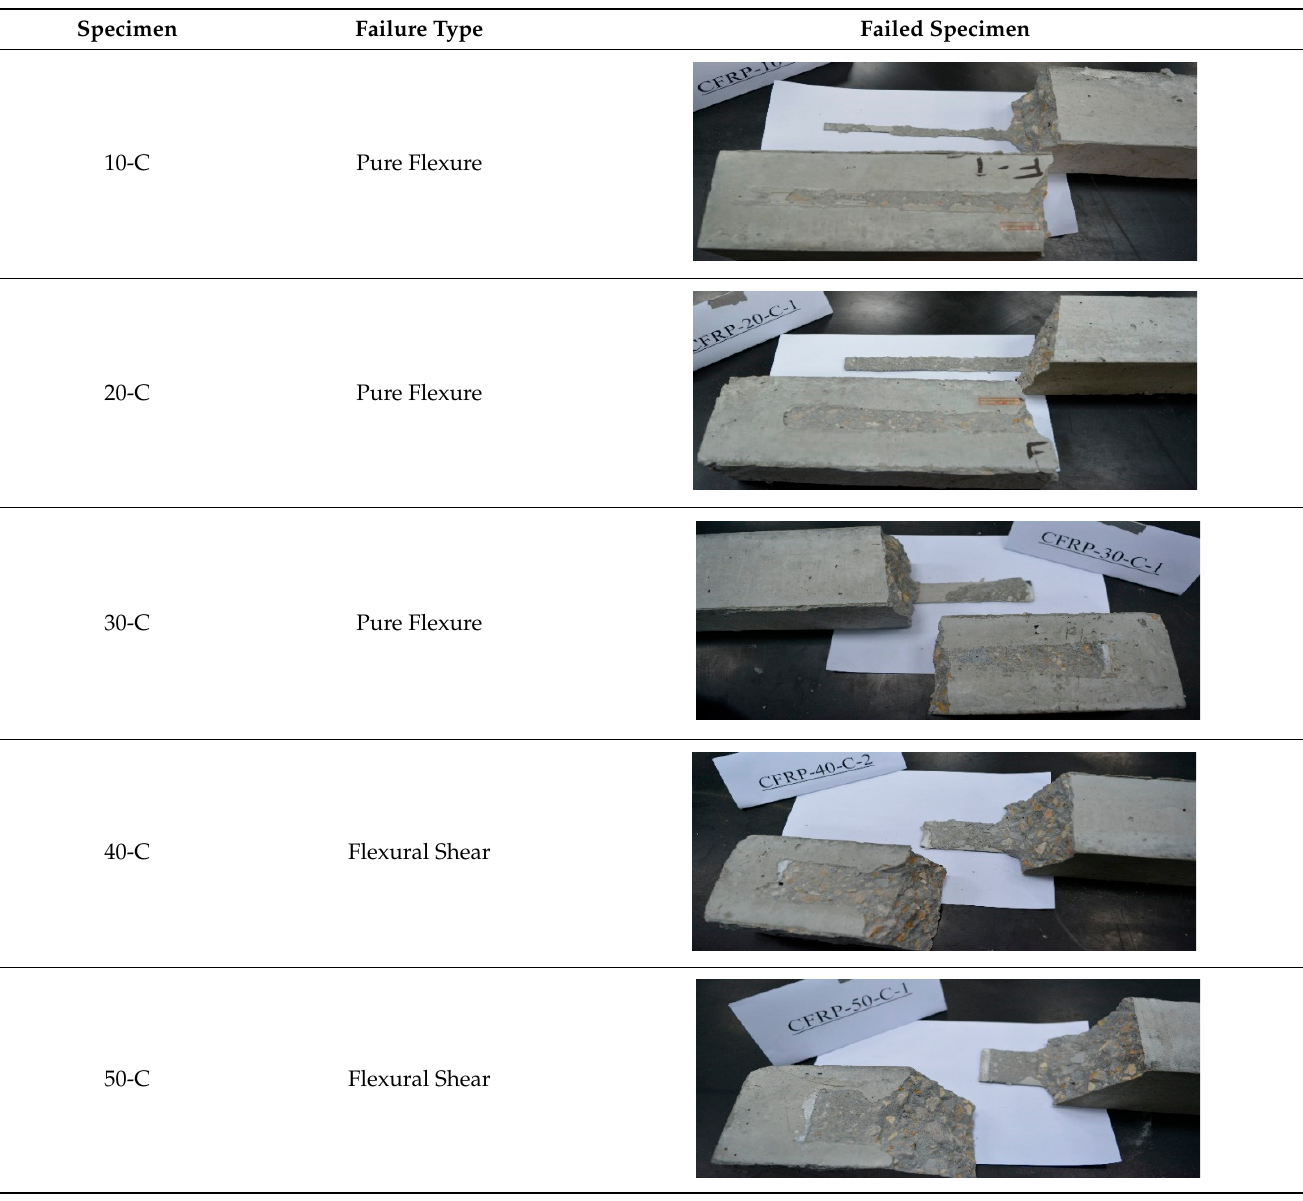
Table 8. Flexure and shear crack propagation of the tested beam samples.